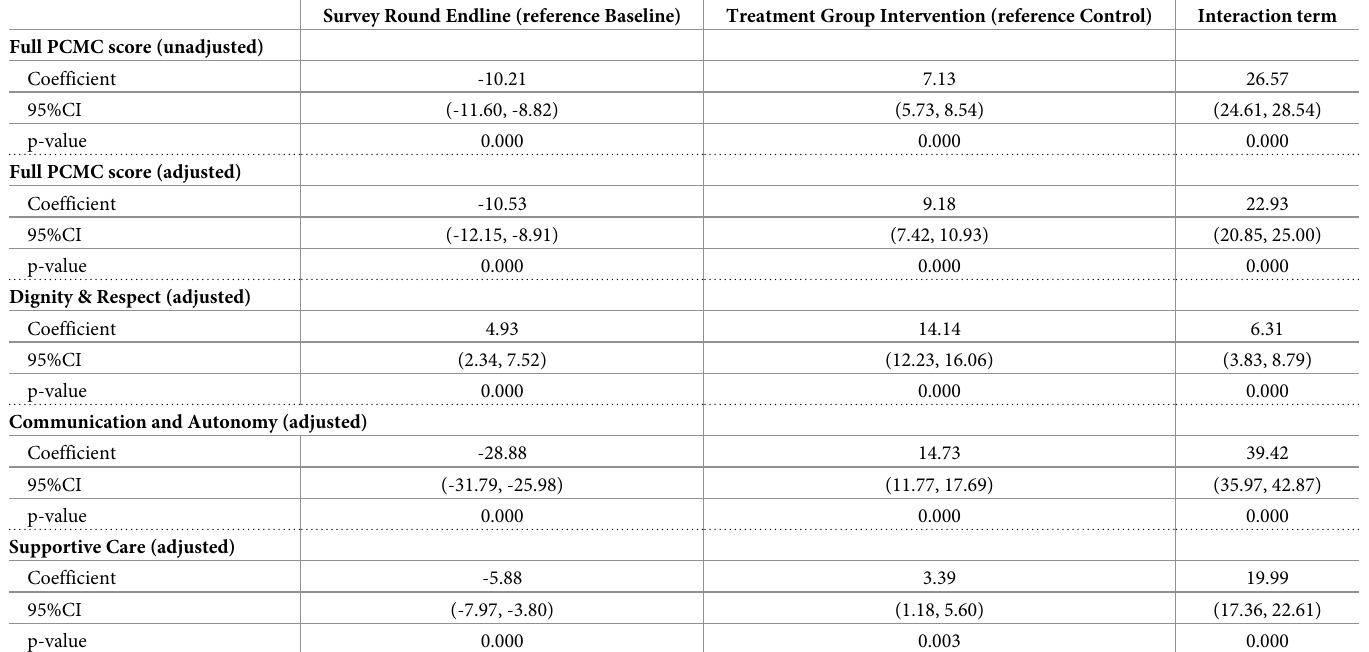
Table 3. Difference endline-minus-baseline, by intervention/control, for each